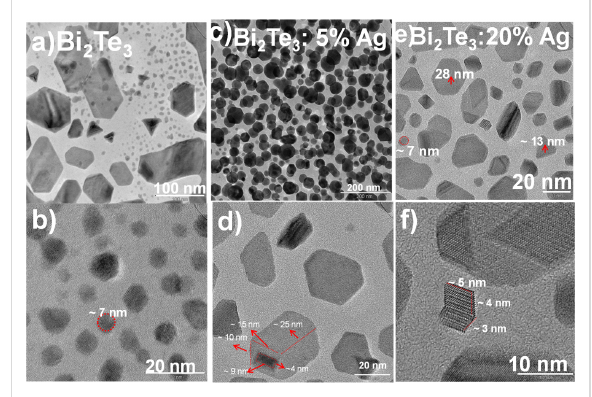
Figure 3: (a) TEM and (b) HRTEM images of Bi 2 Te 3 with 0% Ag, (c, d) for 5% Ag, (e, f) 20% Ag annealed at 573 K.